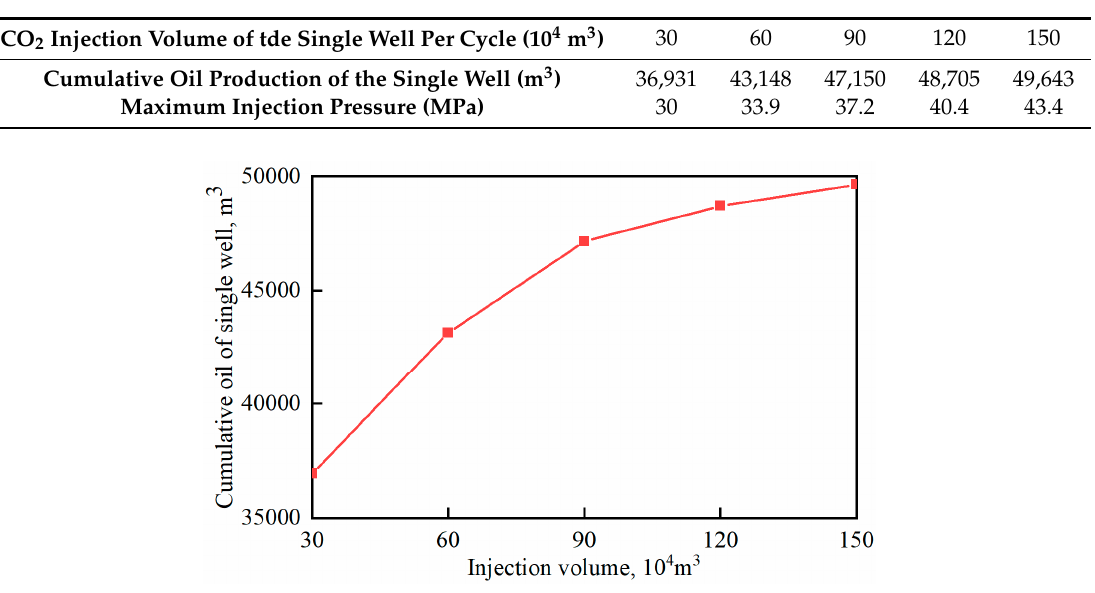
Table 10. Soaking time in different schemes.